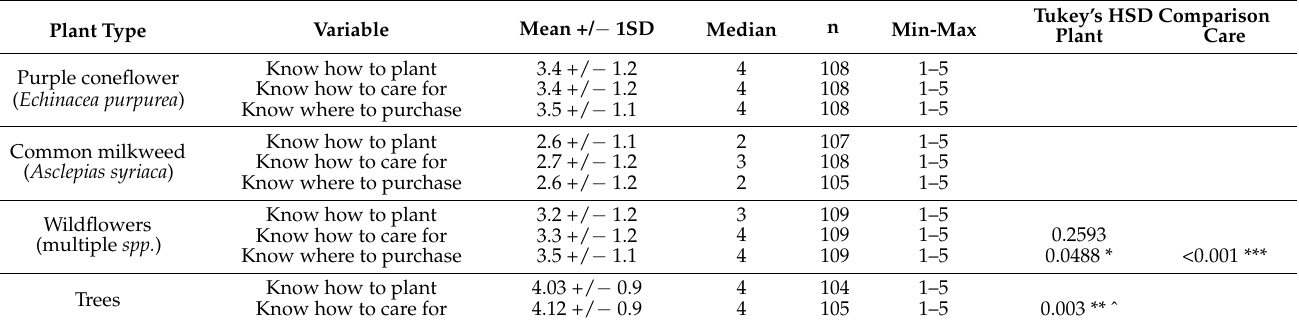
Table 2. Summary statistics for reported knowledge of planting, caring for, and purchasing the three pollinator-beneficial plants shown in the survey (as well as for trees as a comparison group). Mean +/ − 1 standard deviation (SD) and median for reported knowledge of where to purchase, how to plant, and how to care for purple coneflower, common milkweed and wildflowers. Note that the “where to purchase trees” question was not included in the survey instrument. We conducted three one-way repeated-measures ANOVAs to test whether the mean reported knowledge about how to plant, care for, or purchase each of the plants shown in the survey was different. The groups are the reported knowledge categories. The plant types were Echinacea purpurea , Asclepias syriaca , and wildflower prairie (multiple species of native plants). Higher values indicate that the respondent believes they are more knowledgeable. The scale varies from 1 to 5, with 5 indicating that the respondent strongly agrees with the statement (e.g., “I know how to care for wildflowers”). A value of one indicates the respondent strongly disagrees with the statement so that a value of three is neutral (“Neither agree nor disagree”). There is no significant difference between the knowledge questions for purple coneflower or common milkweed so not further tests were conducted. For the ANOVA for the wildflowers, the p values reported for the post hoc test of multiple comparisons is Bonferroni adjusted. ˆ To compare responses for caring and planting for trees since the difference between reported knowledge of planting and caring for trees is severely non-normal and there were only two groups a Wilcoxon signed rank test is used. The number of respondents who answered each question is provided in the column labelled n. Asterisks *, **, and *** denote 5%, 1%, and 0.1% levels of significance, respectively when testing the null hypothesis that the coefficients equal